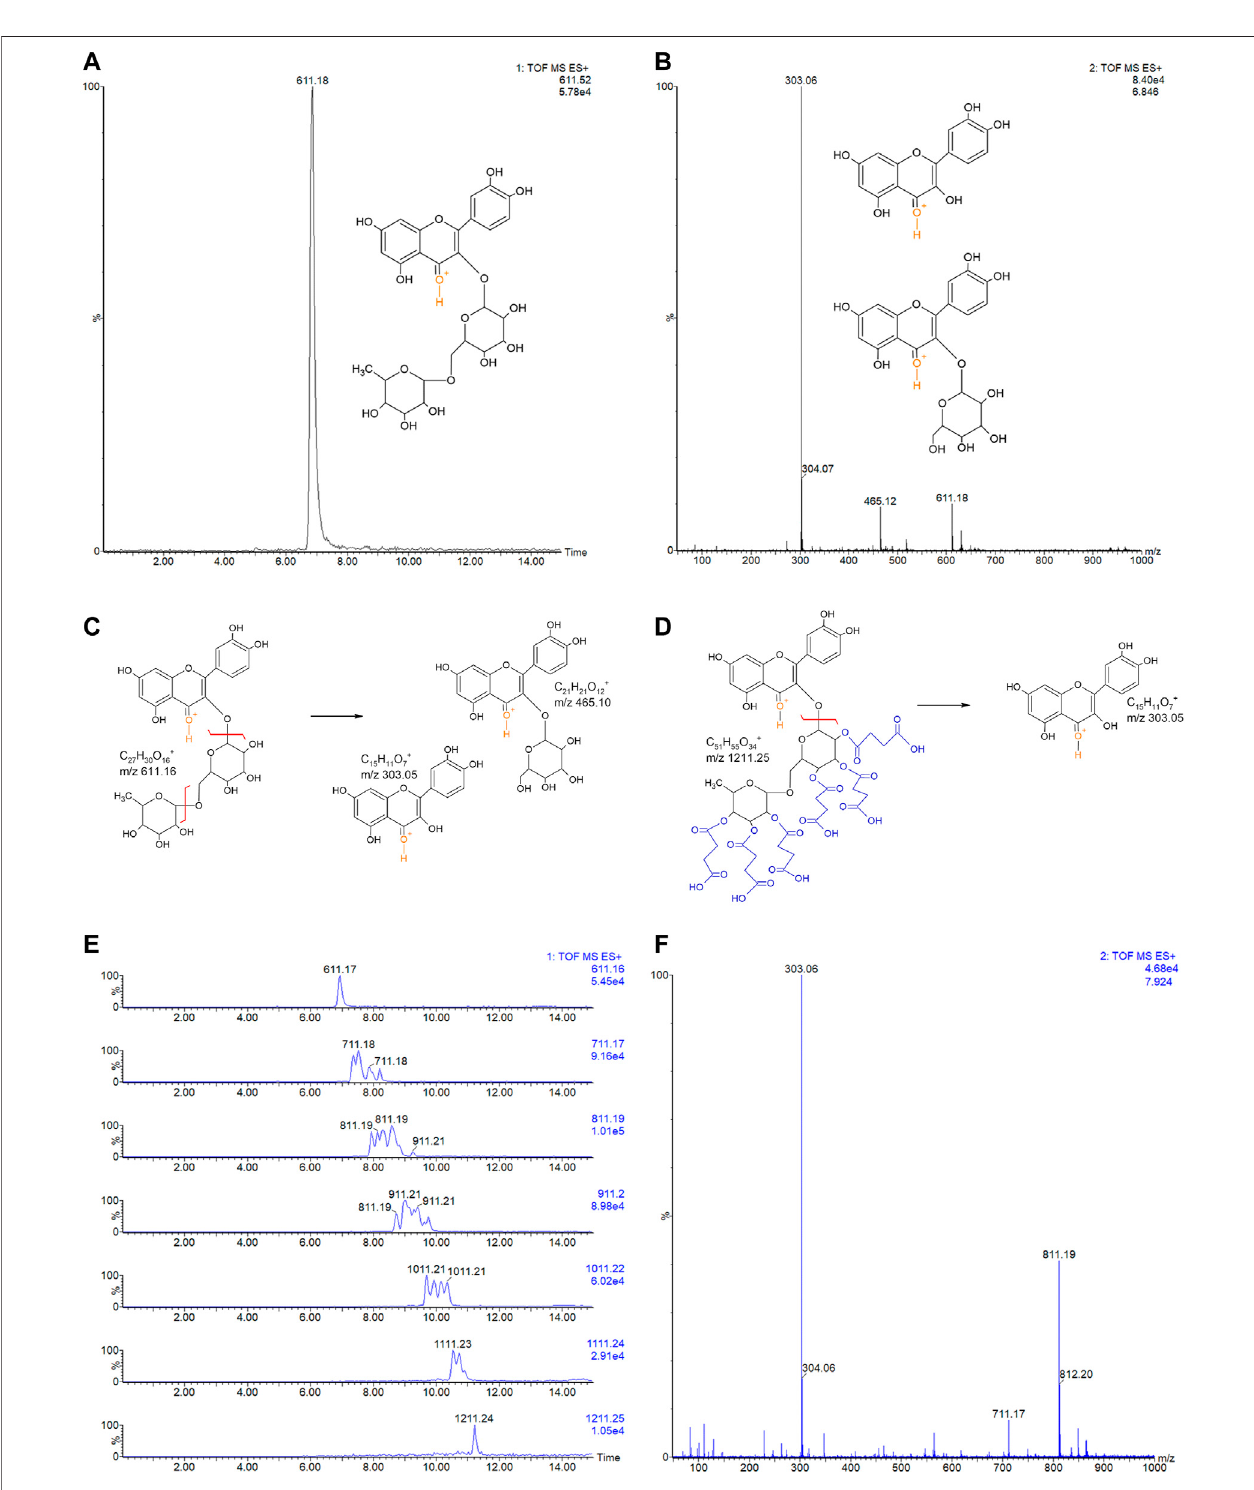
FIGURE 3 | (A) LC-MSE chromatogram of rutin (10 ng, RT 6.84). (B) CID-MS/MS spectrum of rutin: main fragment ions observed at m/z 303.06+ and 465.12+. Remainingprecursorionat611.18+duetotheDIAanalysis.Proposed fragmentationroutesof (C) rutinand (D) RSbyESI-CID-MS/MS. (E) LC-MSEchromatogramsof RS(500 ng)withmultiplesuccinylations(1 – 6),and (F) representativeCID-MS/MSspectrumofRSwith2and3succinylations,atRT7.924.Remainingprecursorions(at m/z 711.17+ and m/z 811.19+) due to the DIA analysis.